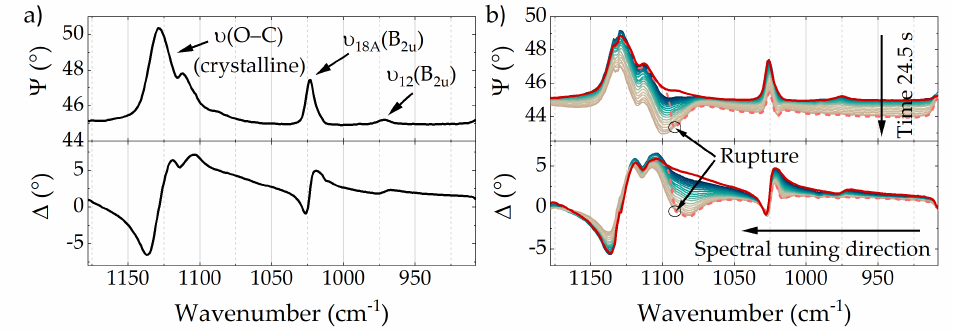
Figure 4. ( a ) ∆ , Ψ -spectra of a 2.5µm BOPET film recorded in a normal incidence transmission measurement. Band assignment according to literature [48]. ( b ) Ellipsometric monitoring of a BOPET film during stretching. The experiment took 24.5s until the film tore during acquisition of the dashed spectra. While the blueish to brownish graphs were recorded during stretching, the red graph indicates the spectra after